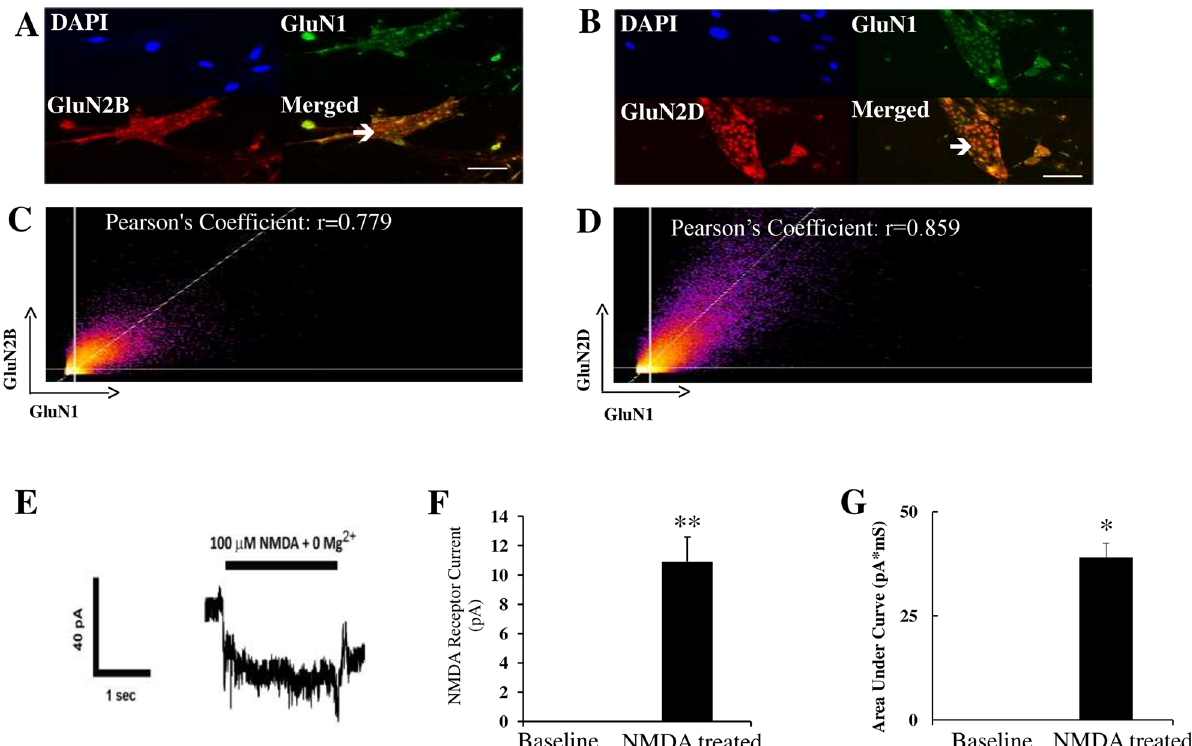
Figure 5. Functional NMDA receptors are localized on the surface of HPASMCs. Immunofluorescence staining was performed on non-permeabilized HPASMCs. Both GluN1 and GluN2 (2B and 2D) subunits were detected on the surface of HPASMCs ( A , B ). GluN1 co-localized with GluN2B ( A ) and GluN2D ( B ) on the surface of HPASMCs, respectively. Results are representative images taken from at least three separate experiments. Scale bar = 100 µM. ( C , D ) are representative scatter plots of each fluorescent pixel from confocal images with GluN1 green fluorescent intensity along the x -axis and GluN2 red fluorescent intensity along the y -axis. The shaded area in the upper right quadrant represents colocalized pixels above background with the associated Pearson correlation coefficient indicated for all colocalized pixels. ( E ) Representative traces for cultured HPASMCs in response to 100 μM NMDA and 10 μM glycine treatment. Cells were clamped at − 50 mV and whole cell recordings were performed. ( F ) NMDA and glycine treatment evoked an inward whole-cell current of 10.9 ± 1.7 pA (Mean ± SE, **p < 0.01, n = 16). ( G ) NMDA and glycine treatment evoked increased AUC compared with baseline (*p < 0.05, n =